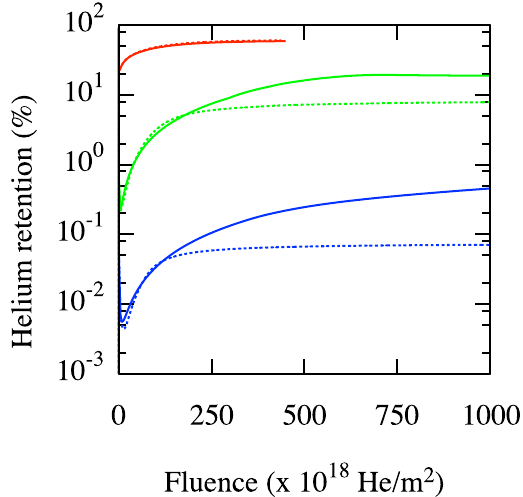
Figure 6. Helium retention as a function of fluence. Red: 4 × 10 25 He/m 2 /s; Green: 4 × 10 23 He/m 2 /s; Blue: 4 × 10 22 He/m 2 /s. Continuous and dashed lines correspond to immobile and mobile complexes, respectively.